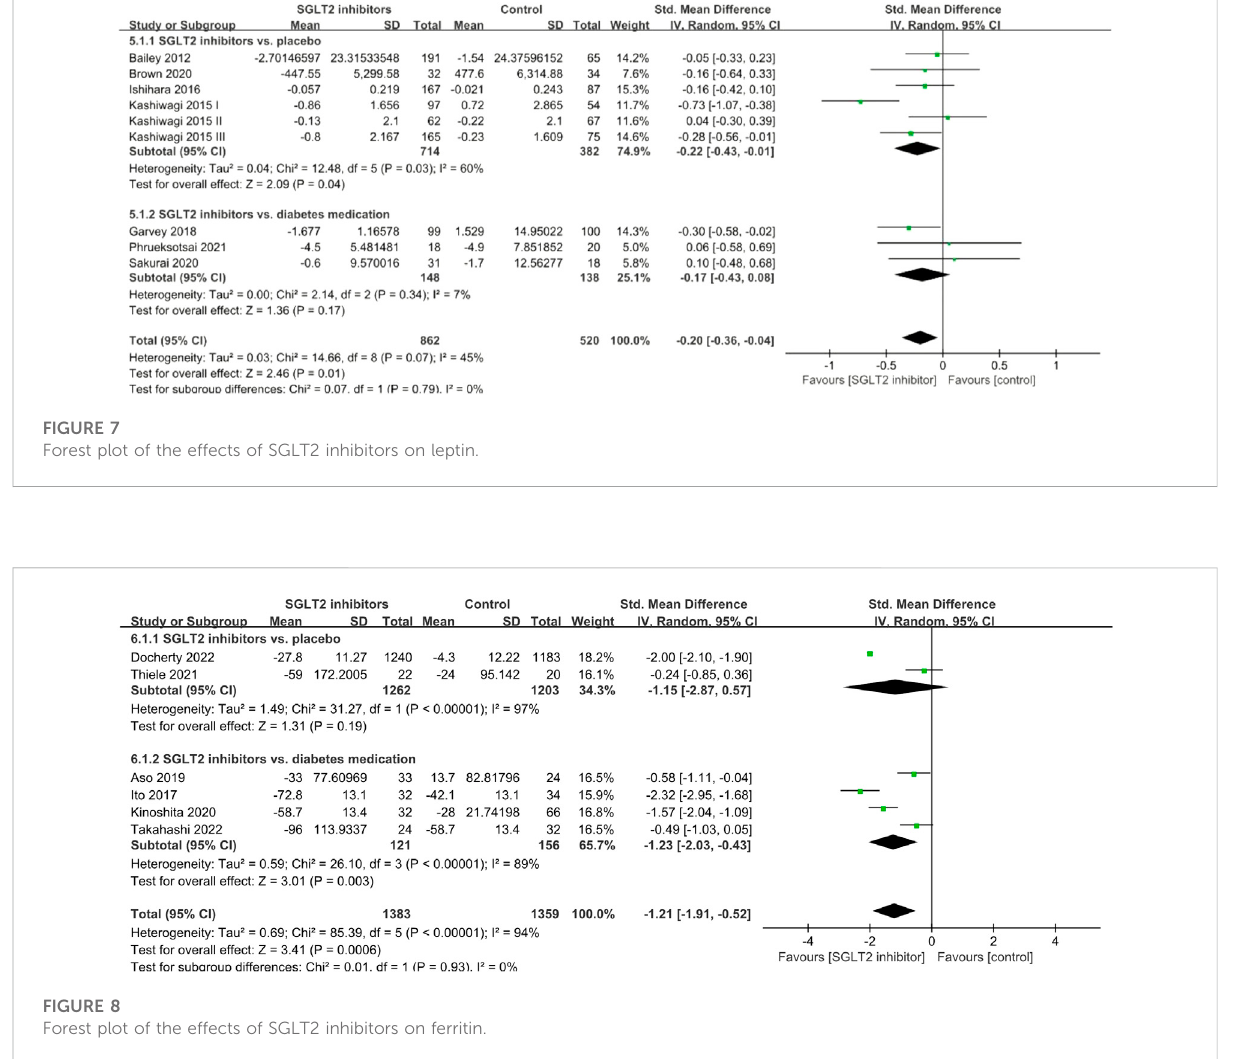
FIGURE 8 Forest plot of the effects of SGLT2 inhibitors on ferritin.